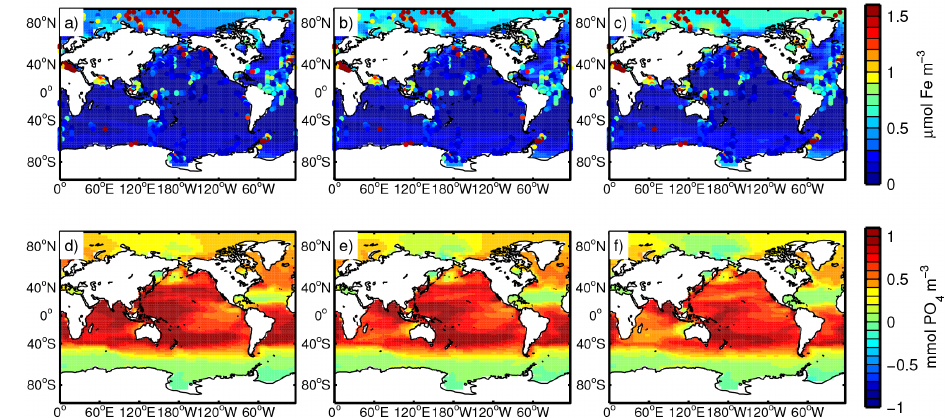
Figure 19. Impact of shutting of the subgrid-scale bathymetry after a 1000 year simulation. Annual mean simulated surface iron concen- trations with observations compiled by Tagliabue et al. (2012) averaged over the first 50m plotted as colored circles on top for experiment BAT08 are shown in (a) , for BAT10 in (b) and for BAT12 in (c) (cf. Table 2). The difference between the annual mean surface phosphate concentrations after 1000 years of experiment BAT08 and LIG08 are shown in (d) , between BAT10 and LIG10 in (e) and between BAT12 and LIG12 in (f) . The experiments are listed in Table